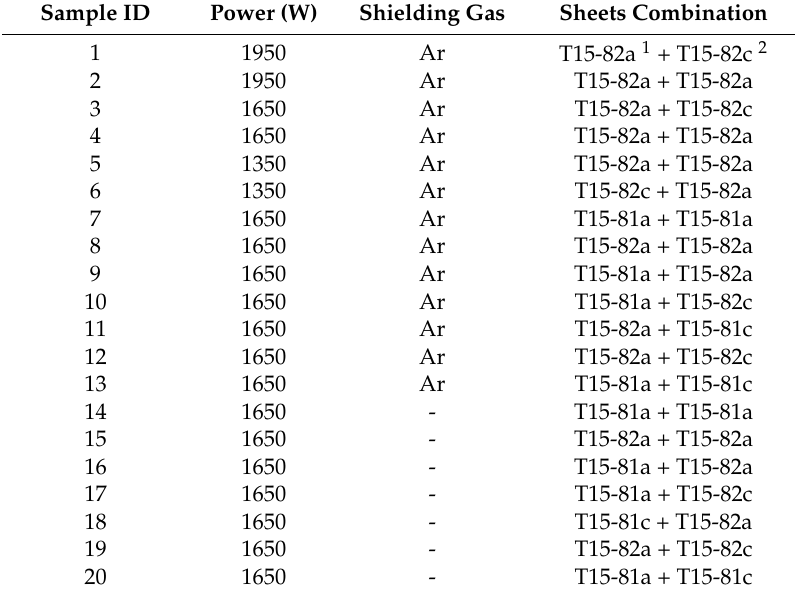
Figure 1. Weld configuration and sampling locations for mini-tensile specimens (C—cross, WM—weld metal). Table 2. Laser welding parameters and configurations of welds of T15-81 and T15-82 sheet metals. Sample